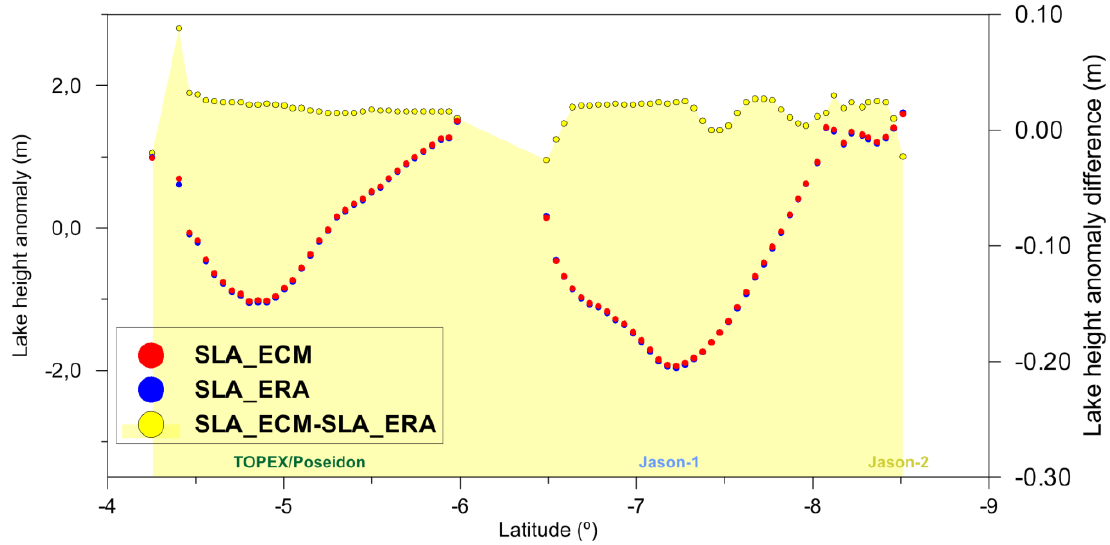
Figure 18. Mean water level anomalies (m) along T/P Pass 222 over Lake Tanganyika, derived using tropospheric (dry and wet) corrections from two models, for the period of J1 Cycles 150–259. Water level heights are with respect to the EGM2008 geoid. A mean lake height of 769 m has been removed. Results for NCEP are not shown, since they are very similar to those from ERA